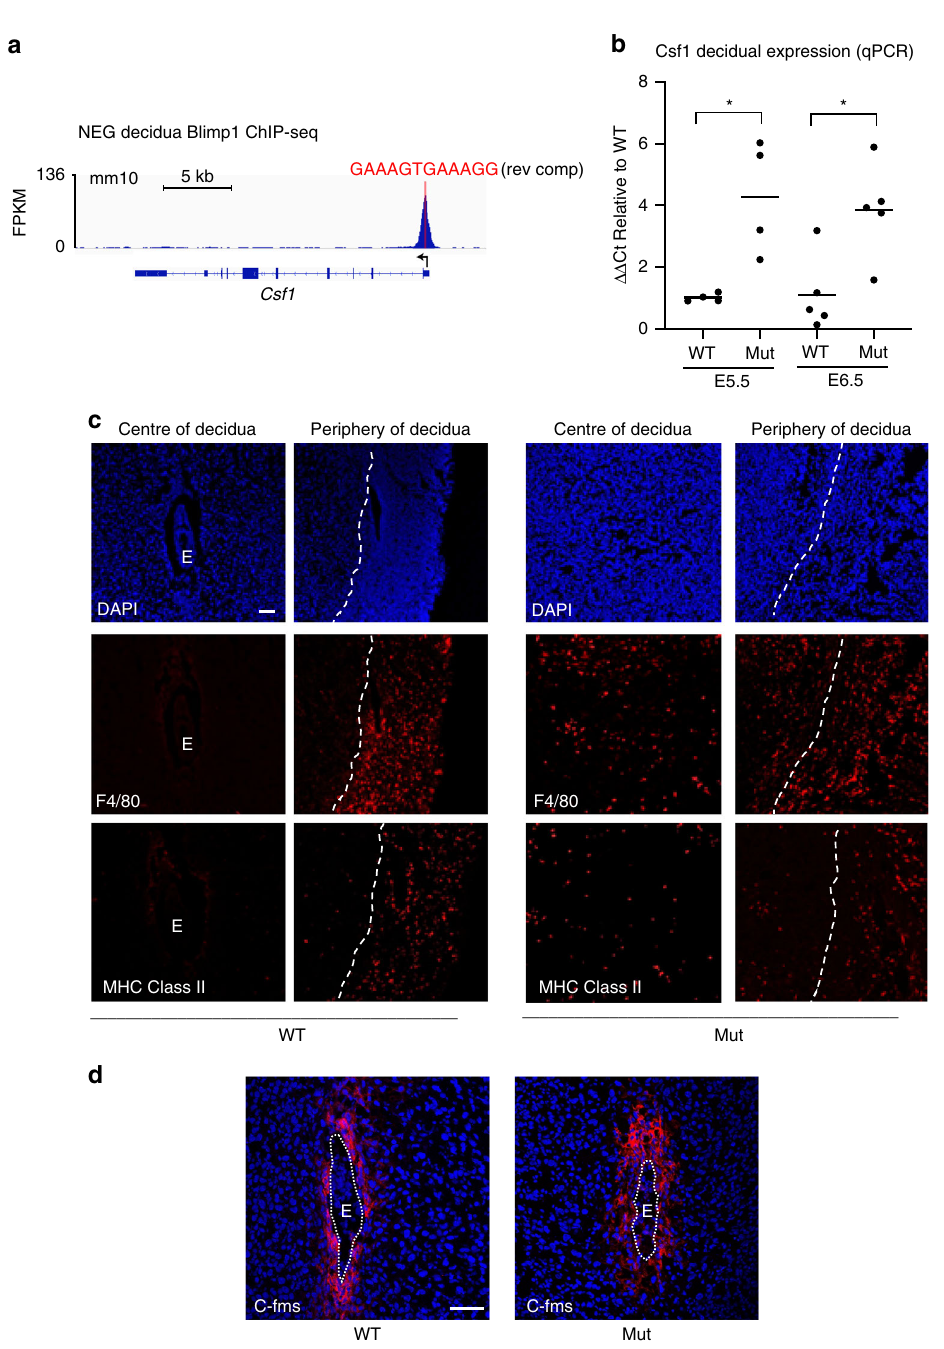
Fig. 6 Blimp1 mutant decidua displays increased Csf1 and macrophage invasion into the PDZ. a ChIP-Seq analysis identi fi es signi fi cant Blimp1 binding at the promoter of the Csf1 gene in mouse decidua. A canonical Blimp1 binding motif underlies the ChIP-seq peak. b QPCR analysis con fi rms upregulated Csf1 expression in Blimp1 mutant decidua at both E5.5 and E6.5. Data from 4 (E5.5) and 5 (E6.5) samples per genotype. Bars represent mean. Two-tailed unpaired Student ’ s t -test * p = 0.0123 for E5.5 and 0.0138 for E6.5. Source data are provided as a Source Data fi le. c IF staining of F4/80 and MHC Class II in E6.5 decidua with DAPI counterstain identi fi es in fi ltration of macrophages into central decidual regions in mutants. In contrast, staining in wild types is largely restricted to the surrounding myometrium ( n = 3 decidua per genotype). White dotted lines mark the boundary between decidual stroma and myometrium. d IF staining of c-fms in E6.5 decidua with DAPI counterstain. C-fms is strongly expressed in the maternal decidua directly adjacent to the embryo in both mutant and wild types. Images are representative of triplicate staining experiments. E = embryo. Scale bars = 100 μ gene promoter in E6.5 mouse decidua (Fig. 6a). Comparison with previously published Blimp1 ChIP-Seq data sets likewise shows Blimp1 occupancy at the Csf1 promoter is widely detectable in other mouse tissue types 21,22,27 . It has been suggested that highly conserved Blimp1 binding sites are largely non-functional 21 .